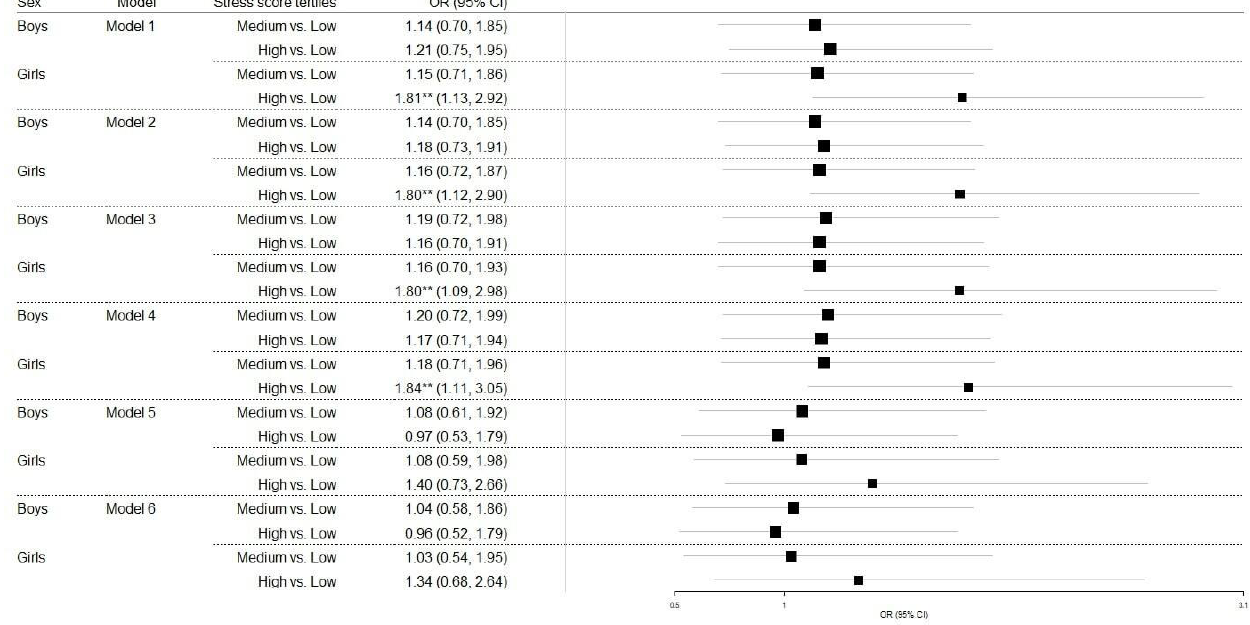
Figure 1. The association between stress and children’s weight status category (overweight/obese vs. normal), adjusted by sex. OR, odds ratio; 95% CI, 95% confidence interval; ** p < 0.05;.